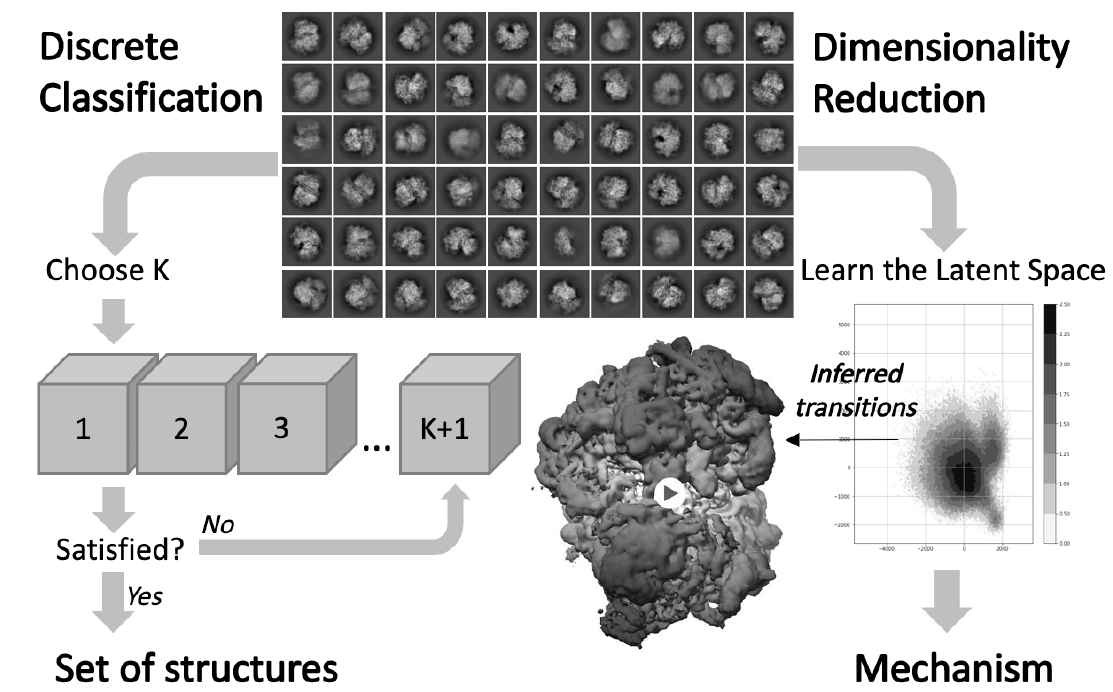
Figure 5. 3D classification and inference of conformational heterogeneity from cryo-EM data. To study discrete heterogeneity (left), traditional 3D classification methods produce a finite number of structures. To study continuous heterogeneity (right), more recent approaches learn a dimensionally reduced representation of the conformational space, from which continuous transition pathways can be visualized to unravel biological